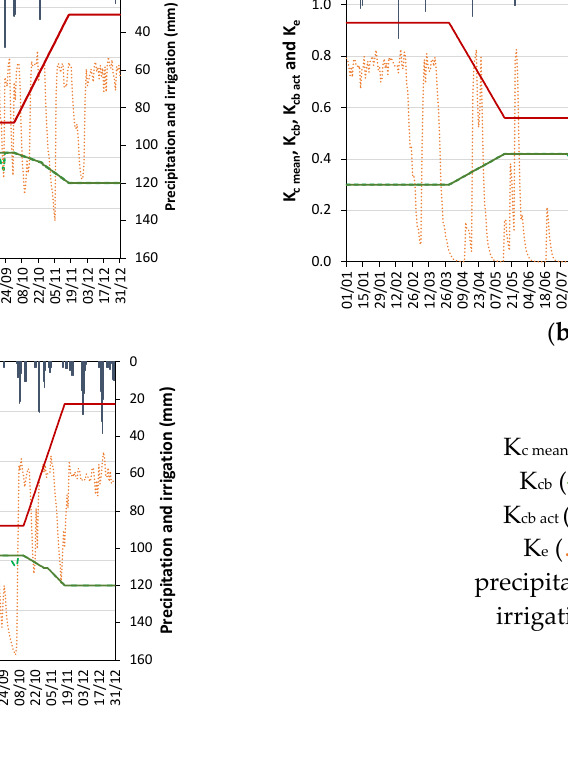
Figure 3. Standard and actual basal crop coefficients (K cb , K cb act ), evaporation coefficient (K e ), and time-averaged standard single crop coefficient (K c mean ) of the olive grove for ( a ) 2009, ( b ) 2010, and ( c ) 2011. Precipitation and irrigation events are also depicted.